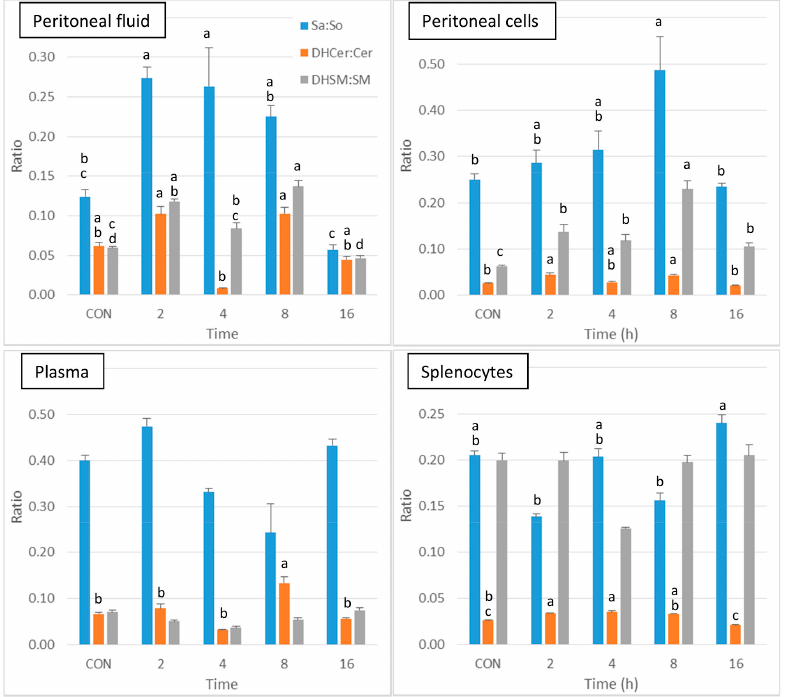
Figure 4. Sphingolipid ratios measured in control mice that received PBS (CON) and in mice after intraperitoneal administration of zymosan at a dose of 0.1 mg/mouse at 2, 4, 8, and 16 h post-zymosan injection. Sphinganine to sphingosine (Sa:So), dihydroceramides to ceramides (DHCer:Cer), and dihydrosphingomyelins to sphingomyelins (DHSM:SM) measured in the peritoneal fluid, peritoneal cells, plasma and the splenocytes. Values are reported as means ± SE, n = 16 for the controls and n = 4, 4, 4, and 8 for the mice treated at 2, 4, 8, and 16 h post-zymosan injection, respectively. Significant differences among groups were investigated using one way ANOVA. Statistically different groups (Duncan) were then identified using different apex letters ( p < 0.05). Any two means having a common letter, are not significantly different at the 5% level of significance.